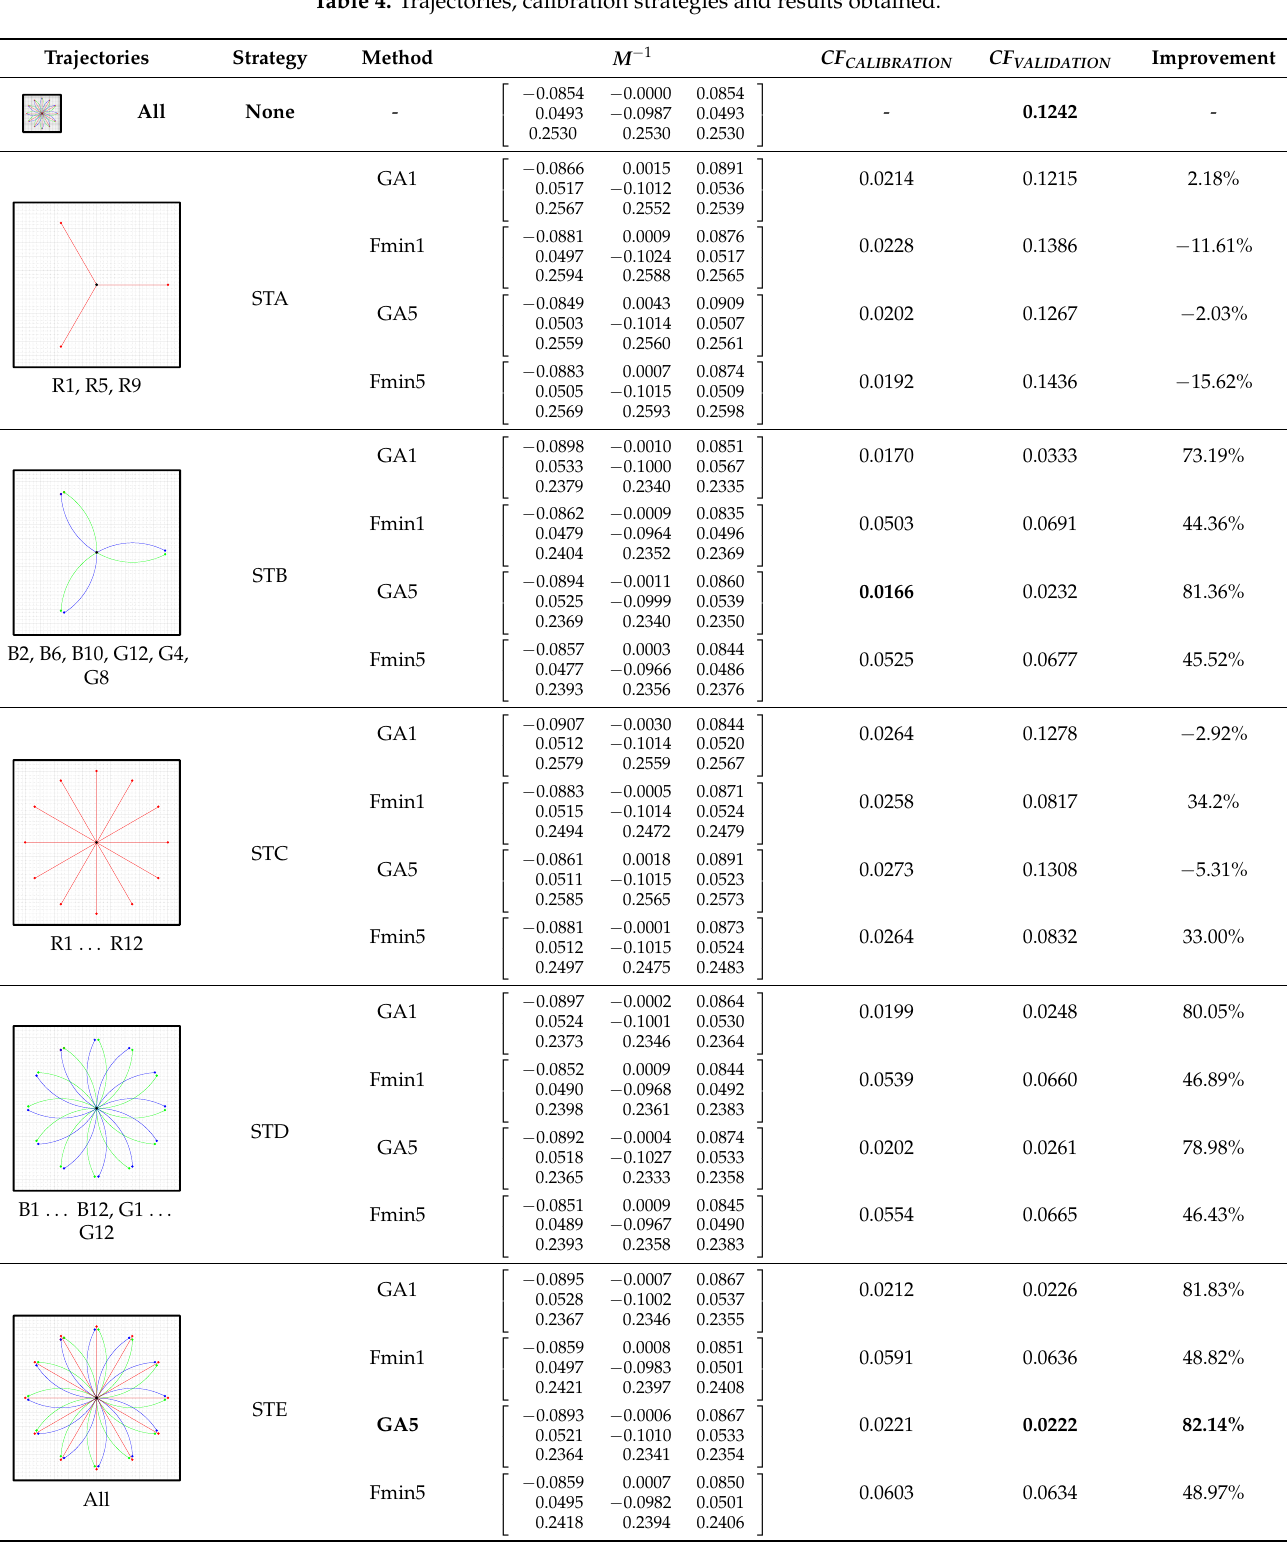
Table 4. Trajectories, calibration strategies and results obtained.